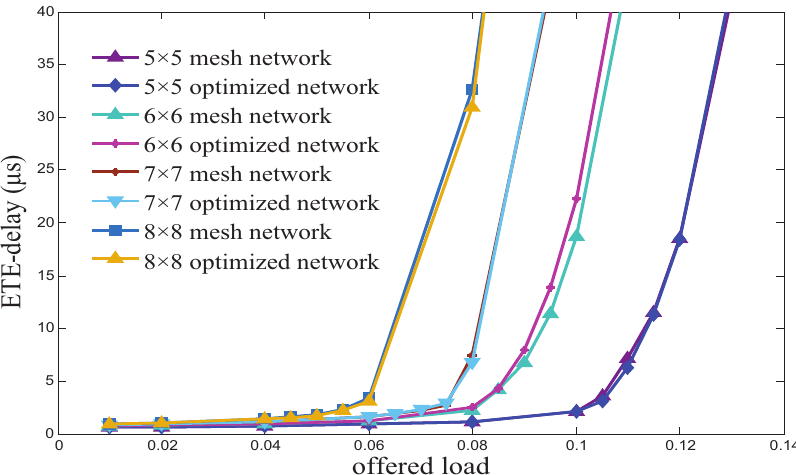
Figure 9. The ETE-delay in M × N mesh-based